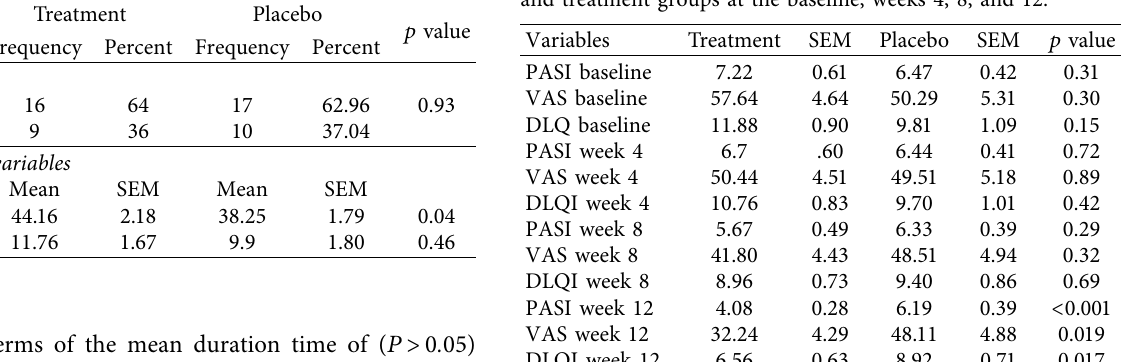
Table 2: Comparison of PASI, VAS, and DLQI scores in placebo and treatment groups at the baseline, weeks 4, 8, and 12.